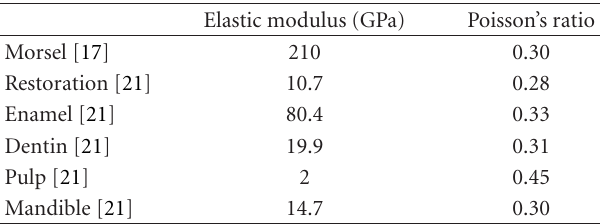
Table 1: Mechanical properties of the morsel, restoration, enamel, dentin, pulp, and mandible